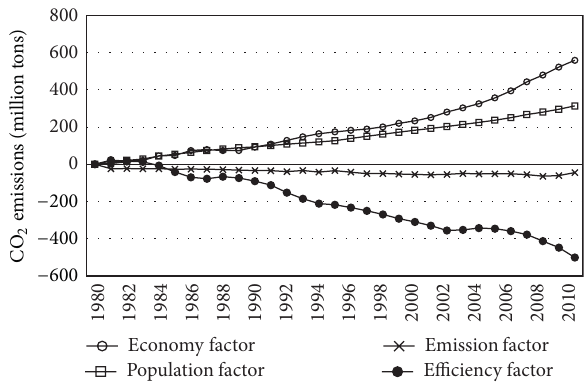
Figure 5: Accumulated CO 2 emissions change of urban residential consumption